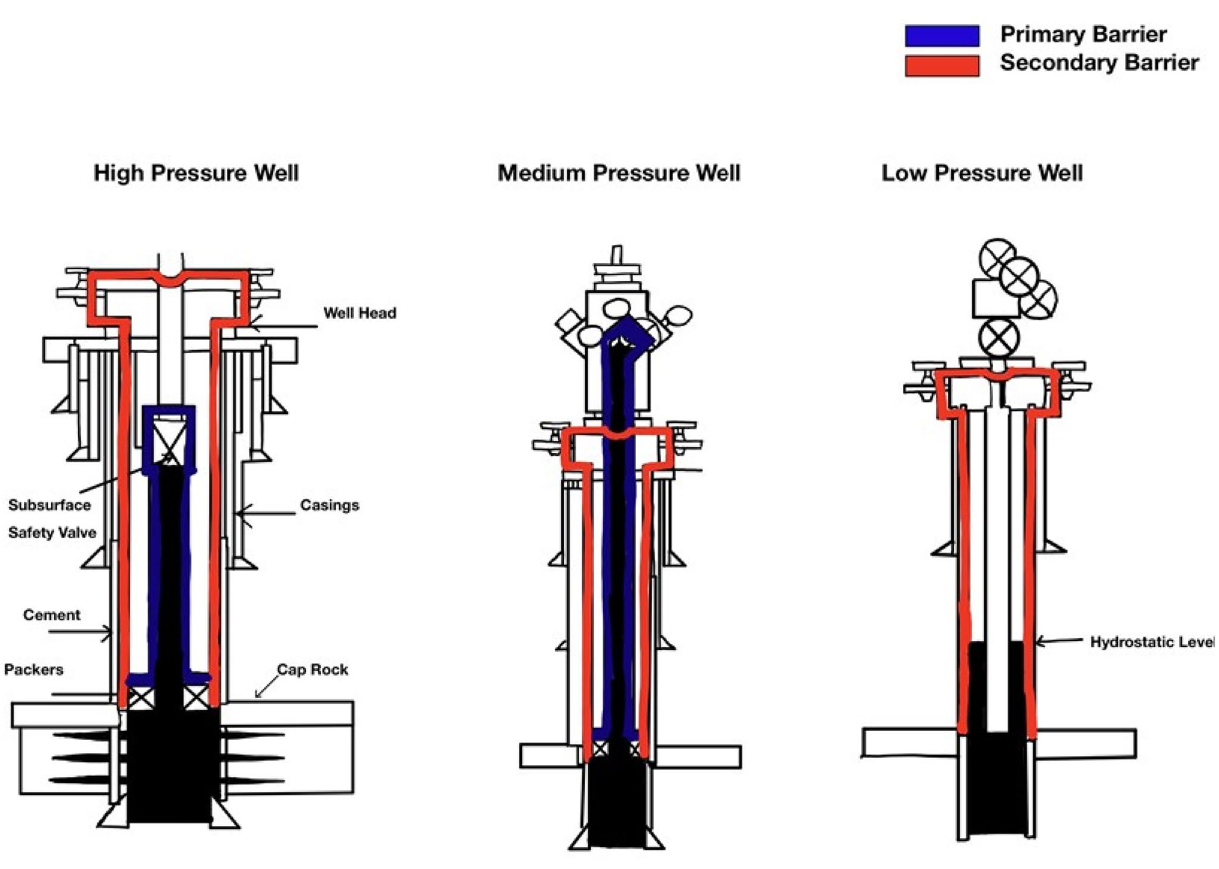
Fig. 1 Barrier Design (PetroWiki Well Integrity)